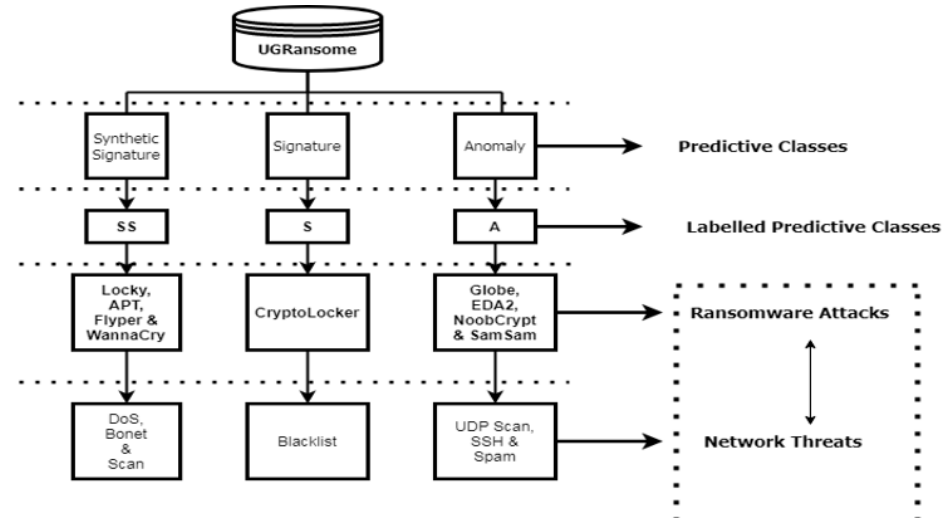
Figure 20. An instance of the UGRansome dataset.